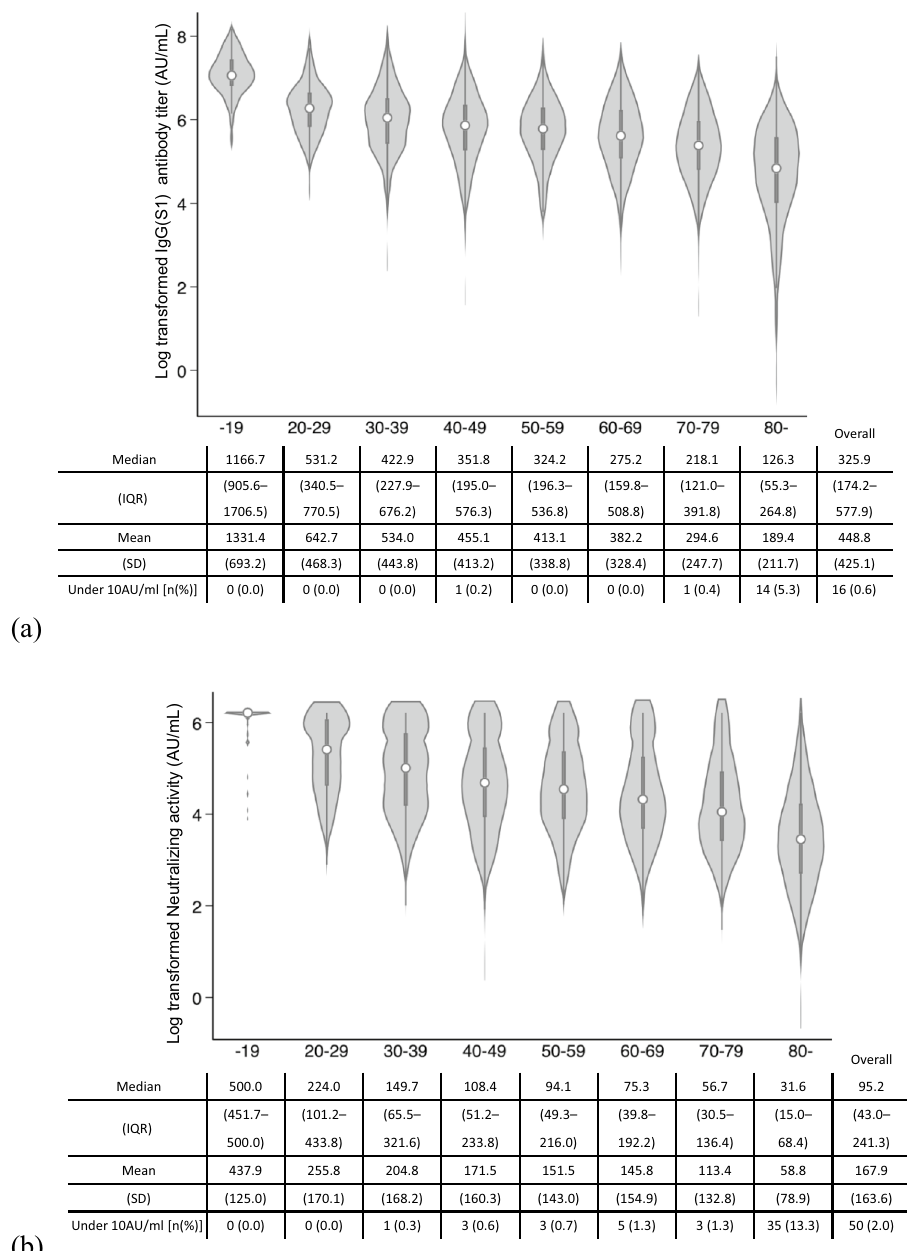
Figure 2. Distribution of ( a) IgG antibody titer against S1 protein and ( b ) neutralizing activity by age groups. Anti-S1 IgG antibody and neutralizing activity were log-transformed. The cut-off values of each antibody were 10 arbitrary units per milliliter